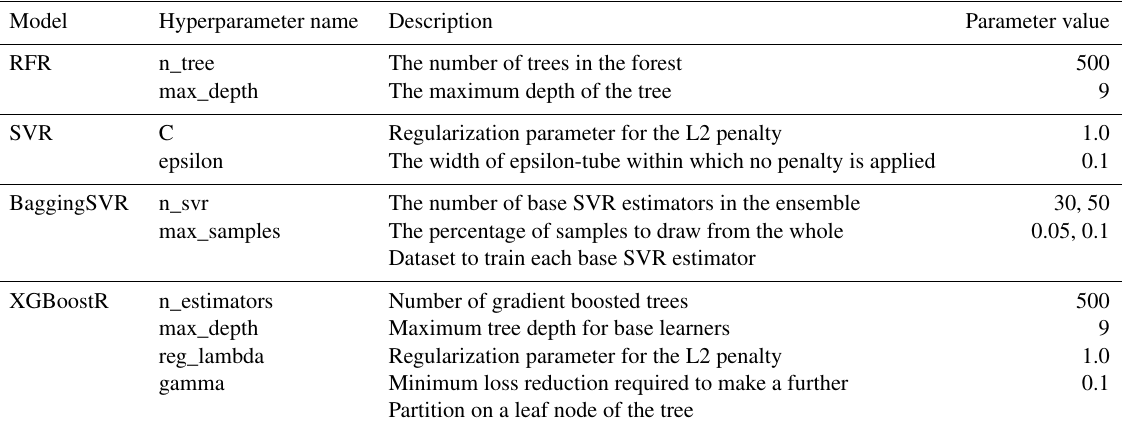
Table A2. Hyperparameters optimization for ML models. For BaggingSVR, we choose n_svr=40 and max_samples=0.05 for the case of 100m, n_svr=50 and max_samples=0.1 for the case of